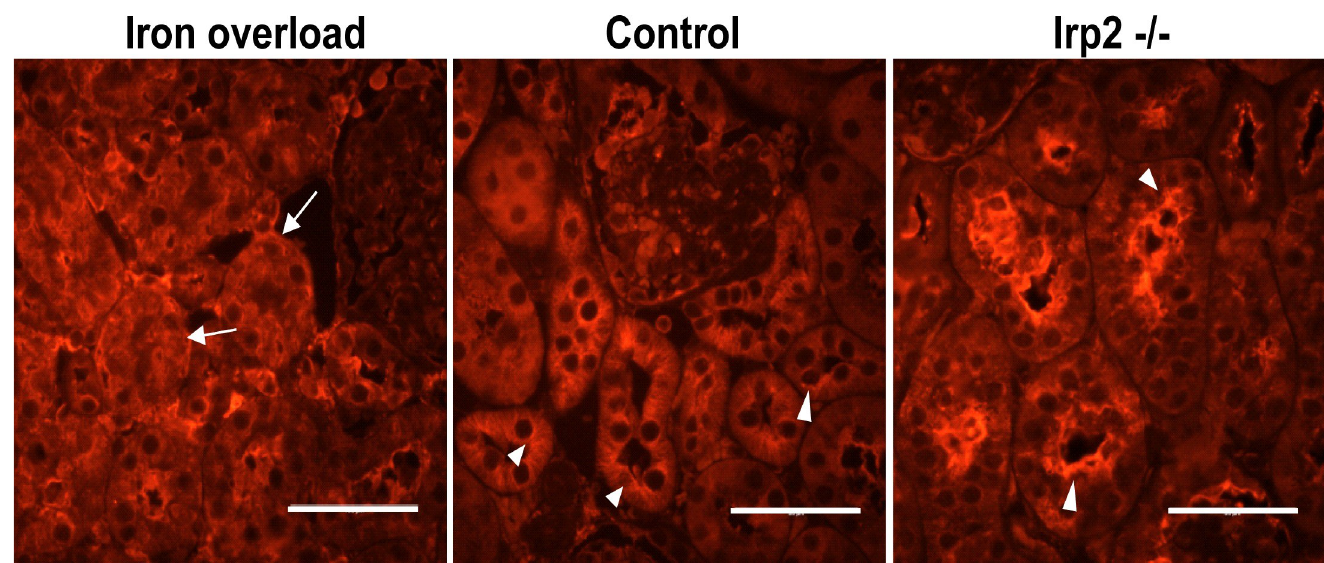
Fig 4. Ferritin distribution in renal epithelial cells is regulated by the iron status: Kidney sections from control, iron-loaded and Irp2-/- mice were stained with H-ferritin antibody. Ferritin was apically polarized in kidneys from Irp2-/- mice and to some extent also in wild-type control mice (arrow heads). In contrast, in iron overloaded mice ferritin was distributed throughout the cells and also found in basolateral regions (arrows). Scale bar represents 50 μ m.